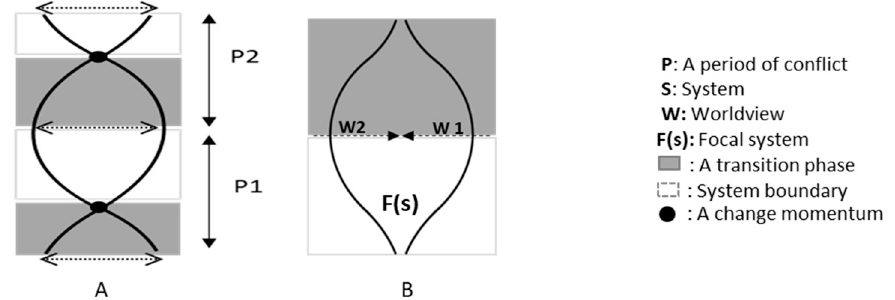
Figure 1. Controversies are an essential property of social relations that facilitate self-organization and stimulate growth and progress in a social system. Figure ( A ) shows how controversies facilitate the transition and growth by creating momentum(s) for change, and figure ( B ) provides a detailed perspective of changes in controversies themselves from one momentum to